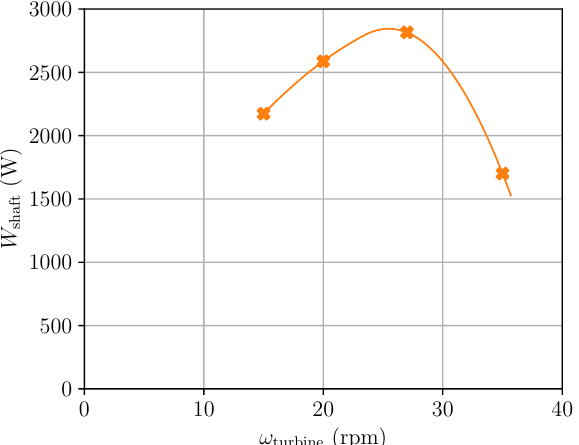
Figure 7. Four turbine shaft power readings carried out in full CFD calculations of the WVPP (individ- ual crosses with a trend curve added as a thin line), with h 1 = 0.64m and h 2 = 0.56m. Both axes are dimensional (power in W and rotation speed in revolutions per minute). In these four simulations, the mass flow decreased steadily as the turbine speed was increased.